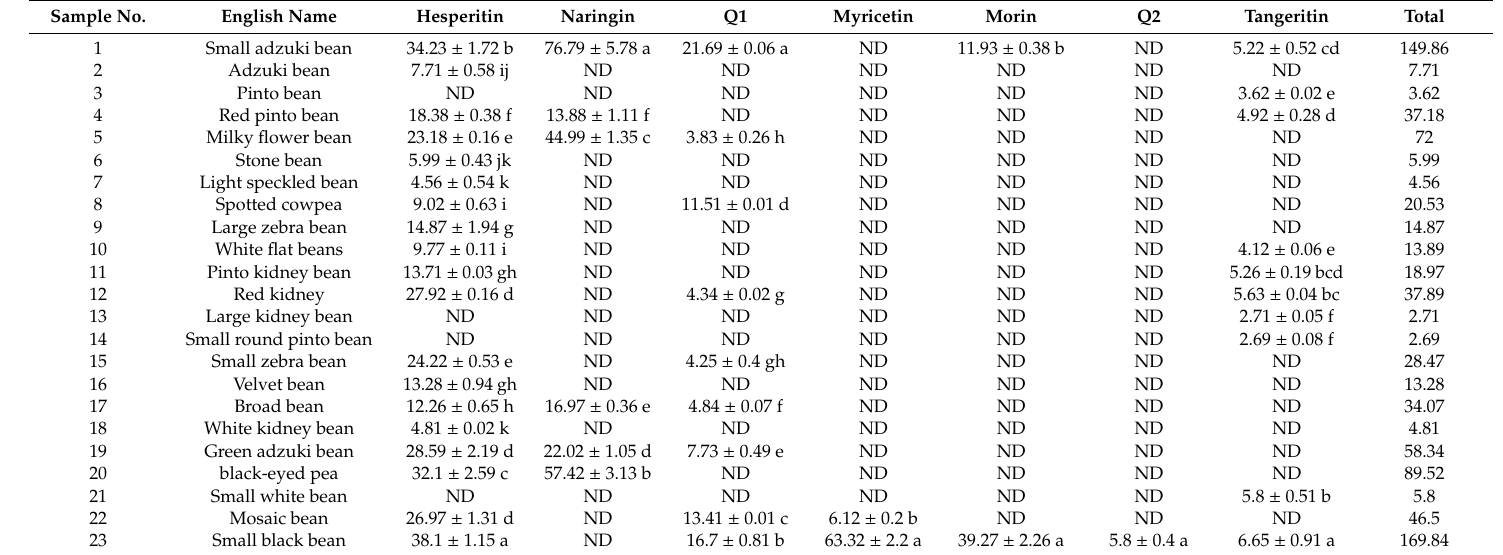
Table 5. The flavonoids content ( µ g / g) of legume